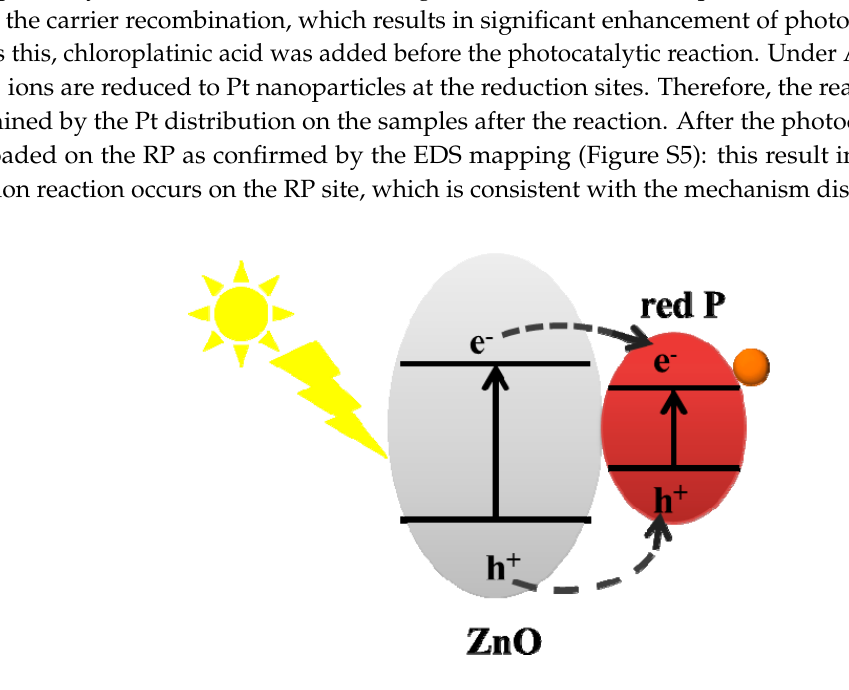
Figure 7. Type—band alignment of ZnO and RP.